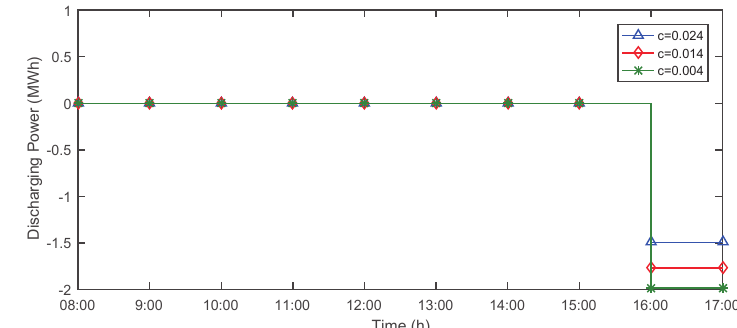
Figure 15. DA energy and regulation bids under different degradation costs.